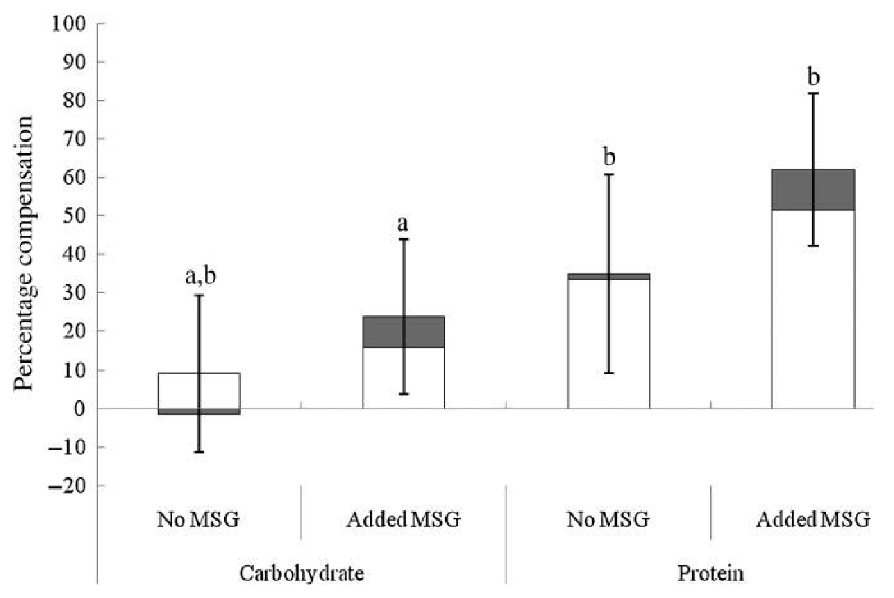
Figure 3. Energy compensation at an ad libitum test meal (pasta main course ( (cid:3) ) and ice cream dessert ( (cid:4) )) after fixed consumption of high-energy carbohydrates and high-energy protein soup pre-loads with and without added monosodium glutamate (MSG). Values are means, with standard errors represented by vertical bars. a, b Mean values with unlike letters were significantly different ( p ≤ 0.05; within-subjects Bonferroni-corrected contrasts). Reproduced from [105].